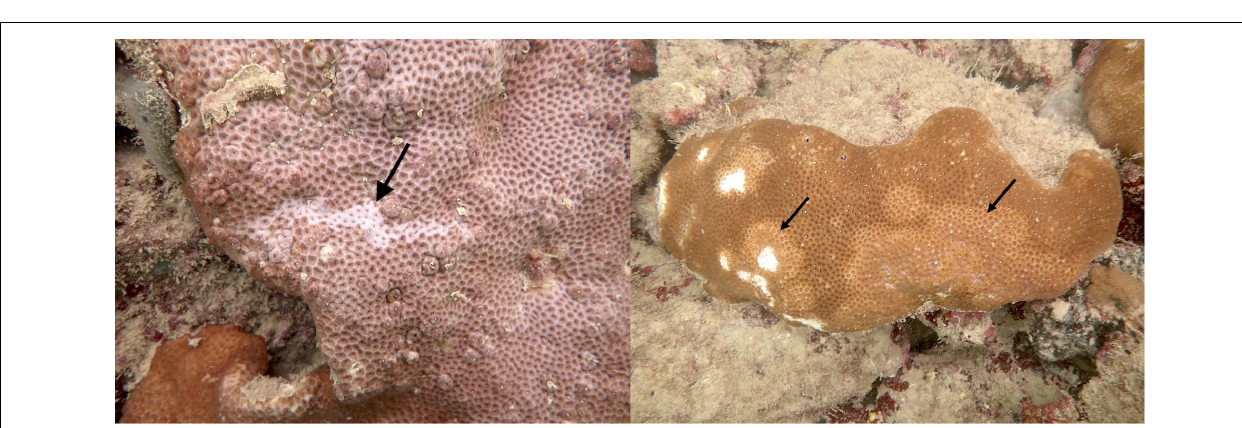
of disease outcome ( X 2 = 38.85, df = 4, and P = 0.0001) and outcome was consistent between regions ( X 2 = 0.033, df = 2, and P = 0.98; Supplementary Table 1 ). Tagged M.